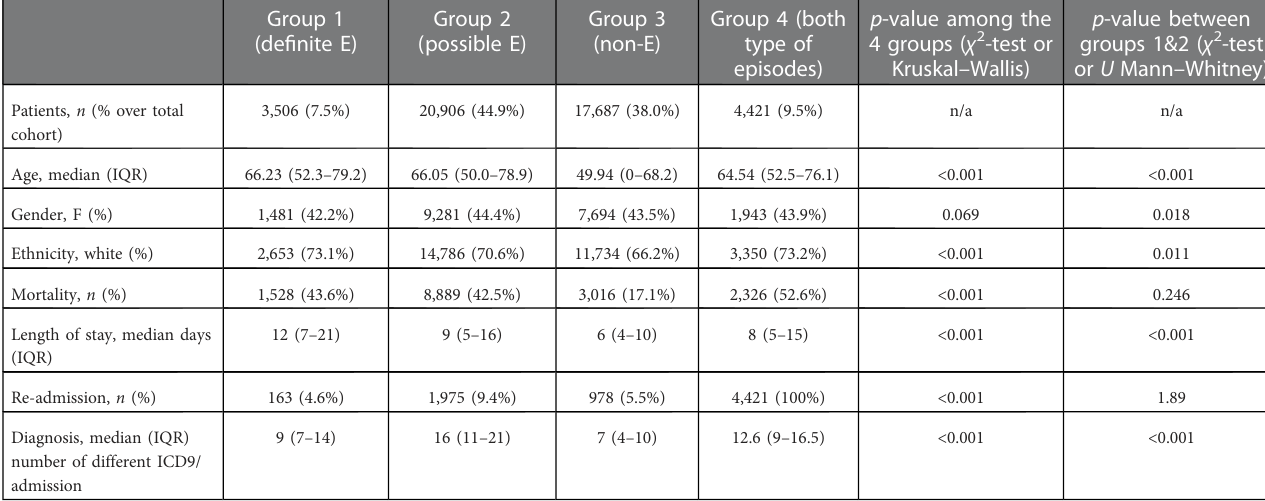
TABLE 2 Classi fi cation of MIMIC patients based on their structured and unstructured